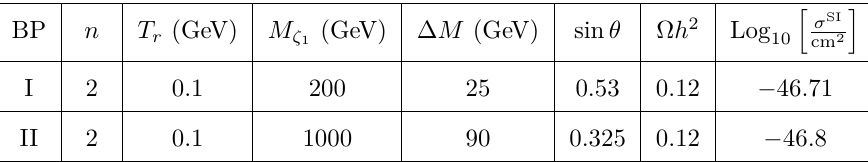
Table 2 . Two sets of relic and SI direct search satisfied points collected from figures 4–5